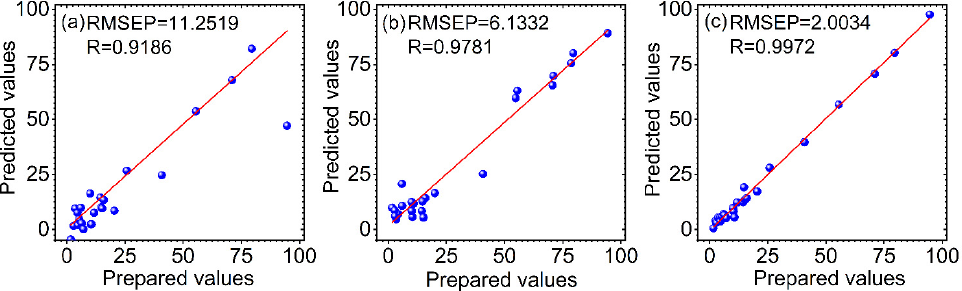
Figure 6. The relationship between the prepared and the predicted values for the prediction set by PLS ( a ), SVR ( b ) and VMD-WMSVR ( c ) for the adulterated herb dataset.